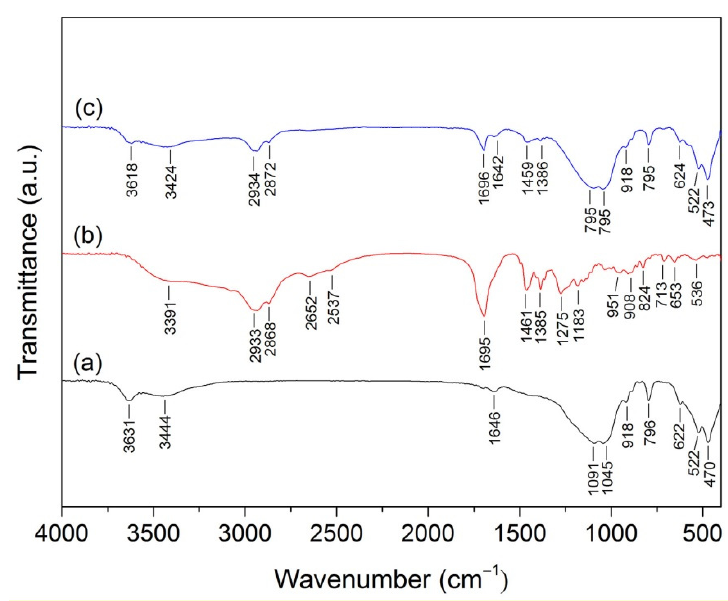
Figure 2. FTIR spectra of ( a ) bentonite, ( b ) gum rosin and ( c )